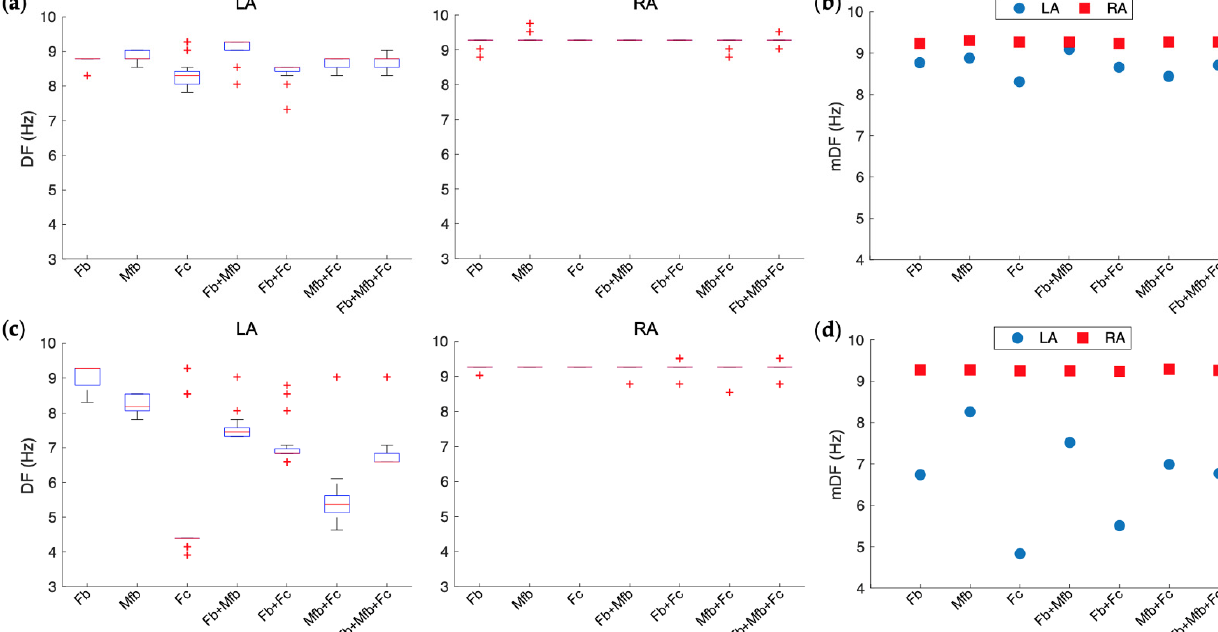
Figure 5. DF boxplots and DF mean (mDF) values in the left (LA) and right (RA) atria, at low ( a , b ), and high ( c , d ) fibrosis density. All fibrotic cells configurations are included in the chart with the corresponding label. The notation used is Fb, Mfb and Fc for fibroblasts, myofibroblasts and fibrocytes, respectively.